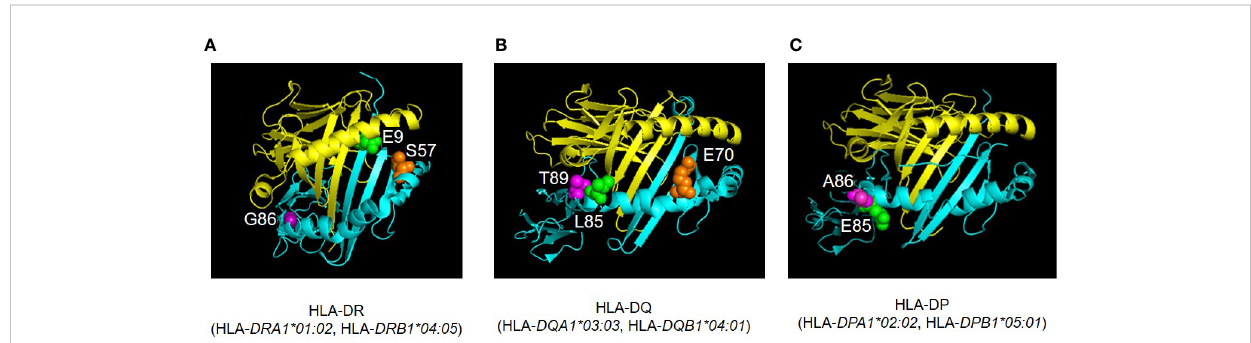
FIGURE 5 Three-dimensional illustration of ICI-T1DM risk-associated amino acid positions were identi fi ed in the current study. The crystal structures of HLA- DR (A) , HLA-DQ (B) , and HLA-DP (C) molecules are established based on Protein Data Bank entries 4IS6, 2NNA, and 3WEX, respectively. The structure of extracellular domains of HLA-class II a and II b chains are shown in yellow and cyan, respectively. Amino acid polymorphic sites are shown as spheres. Amino acid position 9 (E, Glutamic acid, green) and 57 (S, Serine, orange) are located in pocket 9 of HLA-DR molecule (HLA- DRA1*01:02 , HLA- DRB1*04:05 ) (A) . Amino acid position 86 (G, Glycine, purple) composes pocket 1 (A) . Amino acid position 70 (E, Glutamic acid, orange) is associated with both pocket 4 of HLA-DQ (HLA- DQA1*03:03 , HLA- DQB1*04:01 ) (B) . The HLA-DQ b 1 amino acid positions 85 (L, Leucine, green) and 89 (T, Threonine, purple) compose pocket 1 of HLA-DQ molecule (B) . Amino acid positions 85 (Glu, Glutamic acid, green) and 86 (A, Alanine, purple) compose pocket 1 of HLA-DP molecule (HLA- DPA1*02:02 , HLA -DPB1*05:01 ) (C) . Pocket: peptide-binding groove pocket.